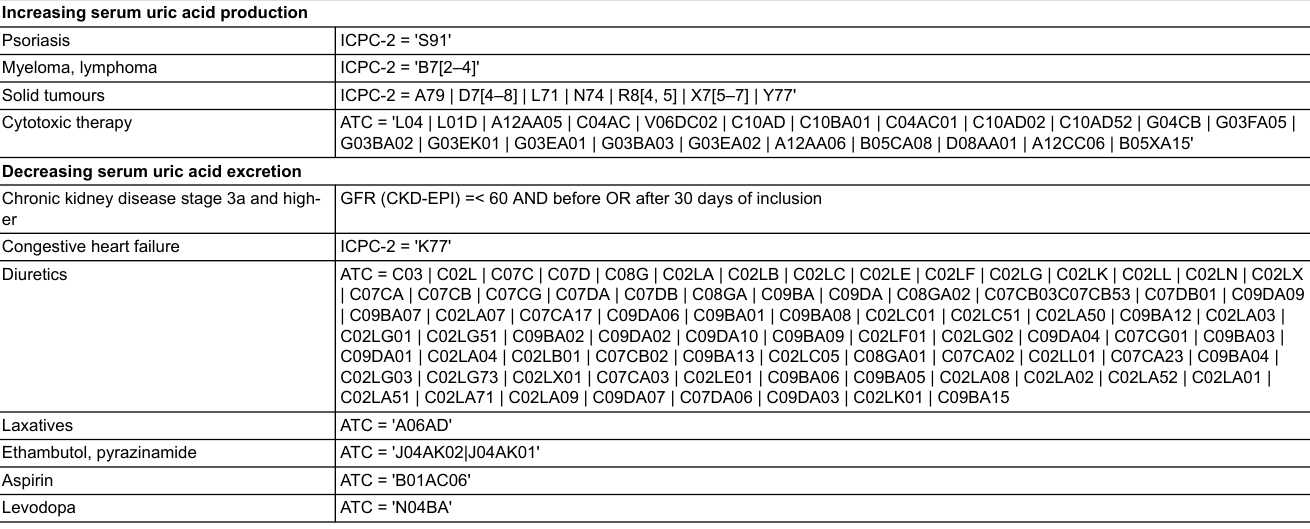
Table S2: Details of definitions to identify risk factors. Increasing serum uric acid